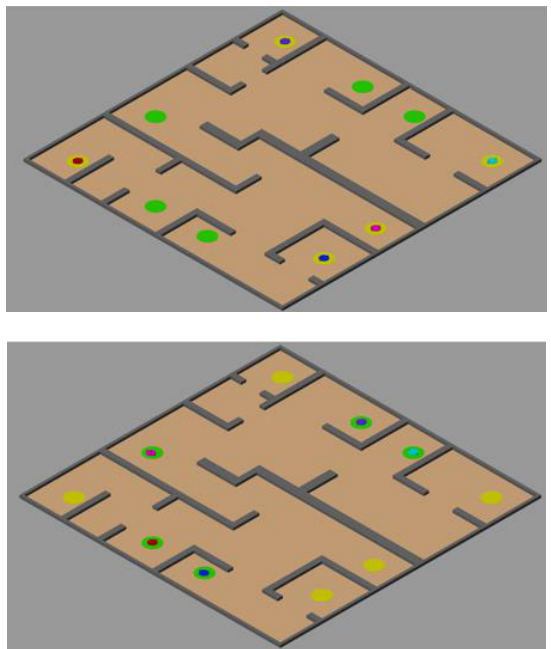
Fig. 6 . The initial and final position of mobile